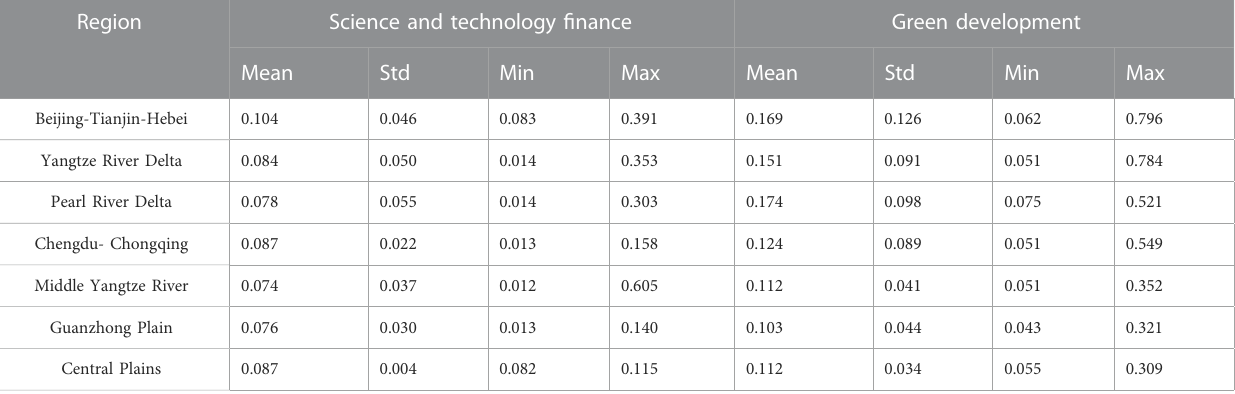
TABLE 7 Descriptive statistics of comprehensive scores of science and technology fi nance and green development in China ’ s seven urban agglomerations.